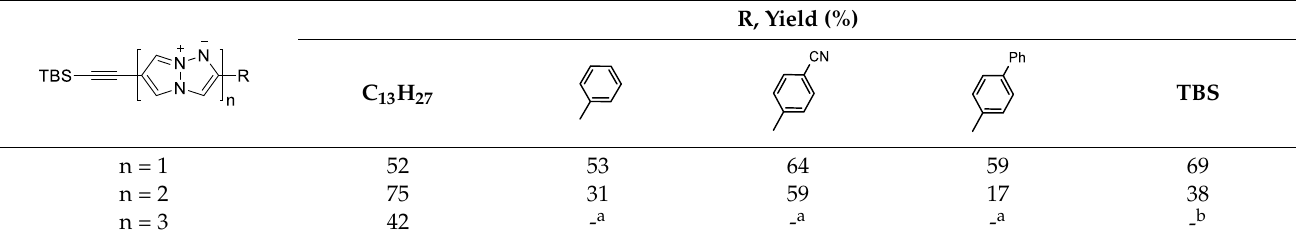
Table 8. Structures and reaction yields of linearly bonded TAPs 35 .